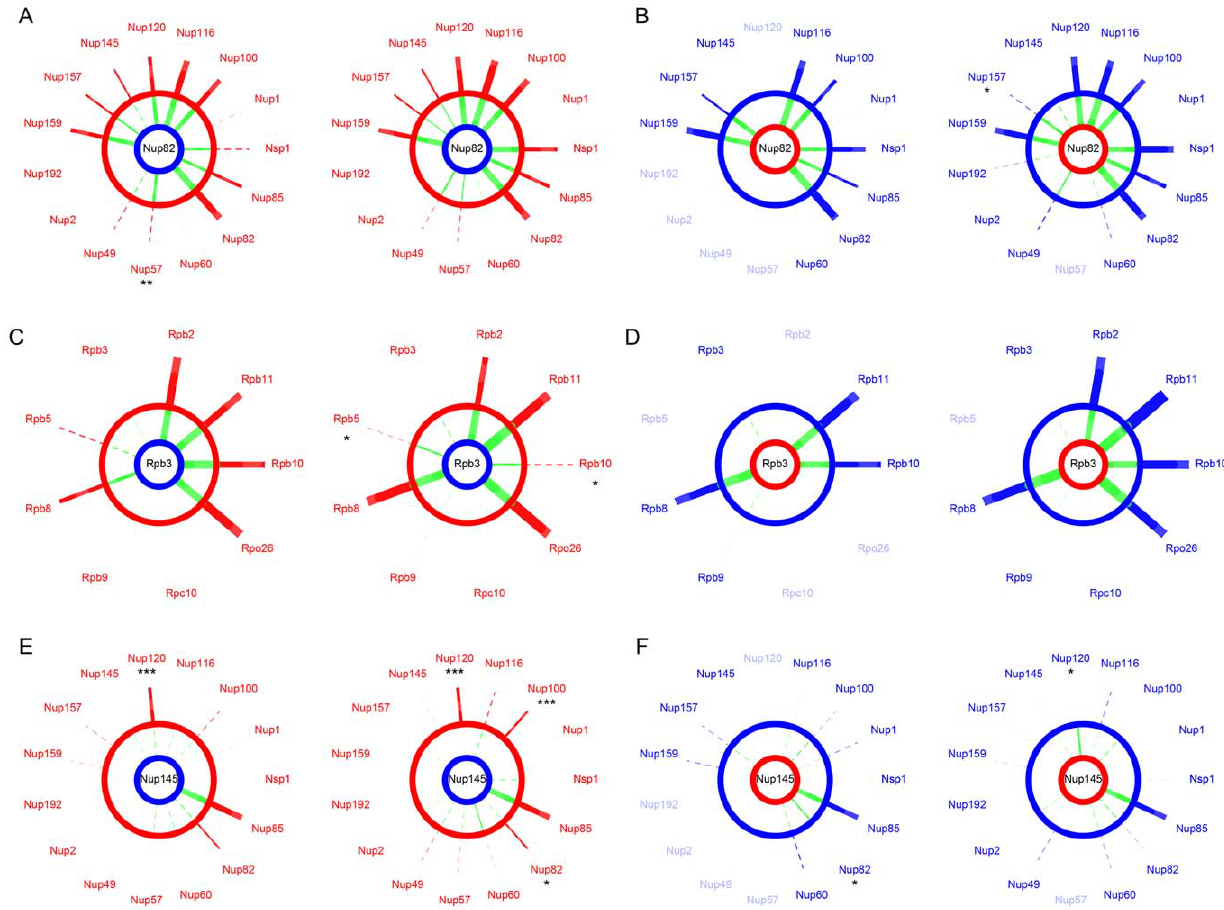
Figure 4. The NPC and RNApII are robust to hybridization. SI values compared between Scer (red) or Skud (blue) and Scer-Skud hybrids (green). Examples of proteins Nup82 ( A–B ) and Nup145 ( E–F ) in the NPC and Rpb3 ( C–D ) in the RNApII. Segment width is proportional to SI (dotted line if SI , t ). For each comparison, networks on left show interactions measured between the protein of interest tagged in MATa (center) and other proteins of the same complex tagged in MAT a . Networks on right show the reciprocal interactions. The protein of interest comes from Scer (red ring) or Skud (blue ring) and is in the species background (outer ring) or in the hybrid background (inner ring). Asterisks indicate whether the SI value measured in hybrid is significantly different from that measured in species (*: p , 0.05; **: p , 0.01; ***: p , 0.001). Only the absence of Scer Nup120- Skud Nup145 is significant in reciprocal comparisons ( E ). Protein names were blurred when strains were unavailable.